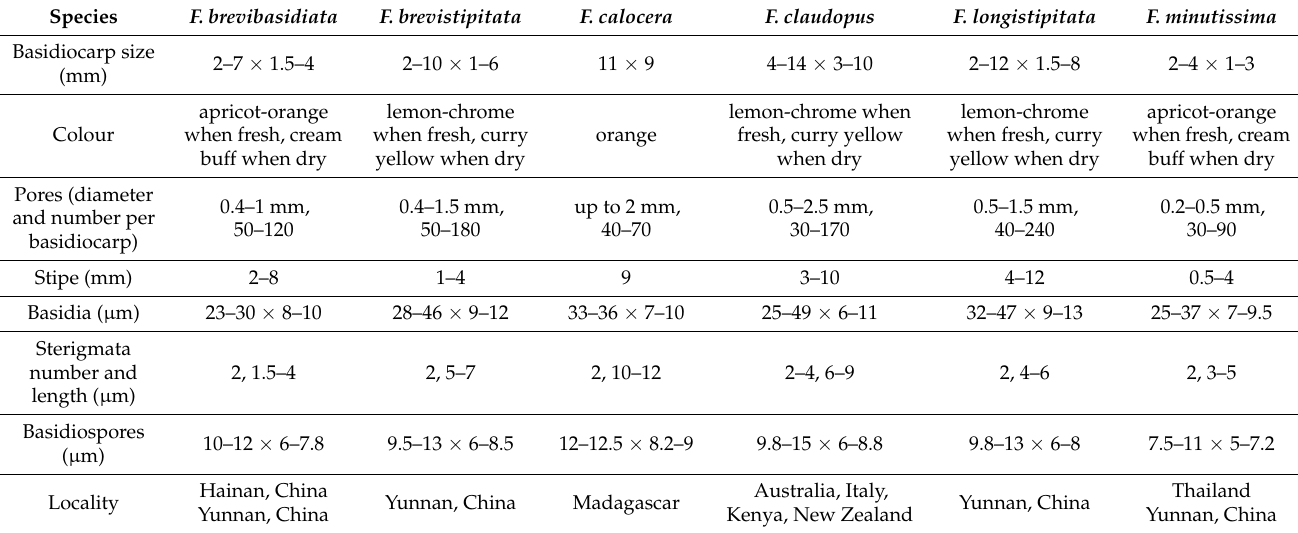
Table 2. A comparison of the characteristics of the species in the Favolaschia calocera